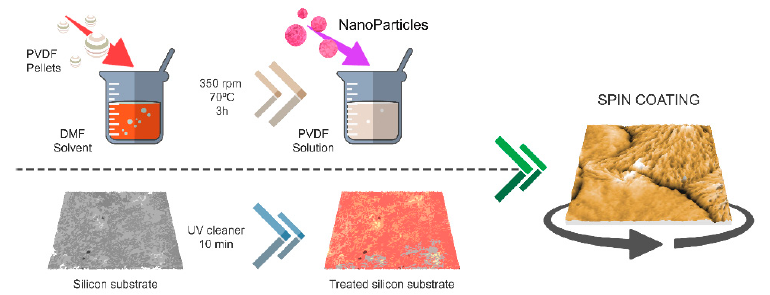
Figure 1. Sketches of neat PVDF and hybrid PVDF–nanoparticle deposition on conductive pretreated substrates by spin coating technique.